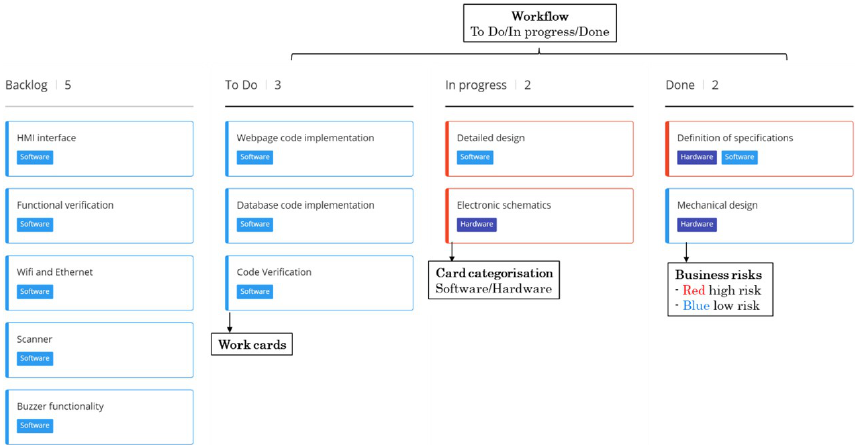
Figure 13. Proposed Agile methodology